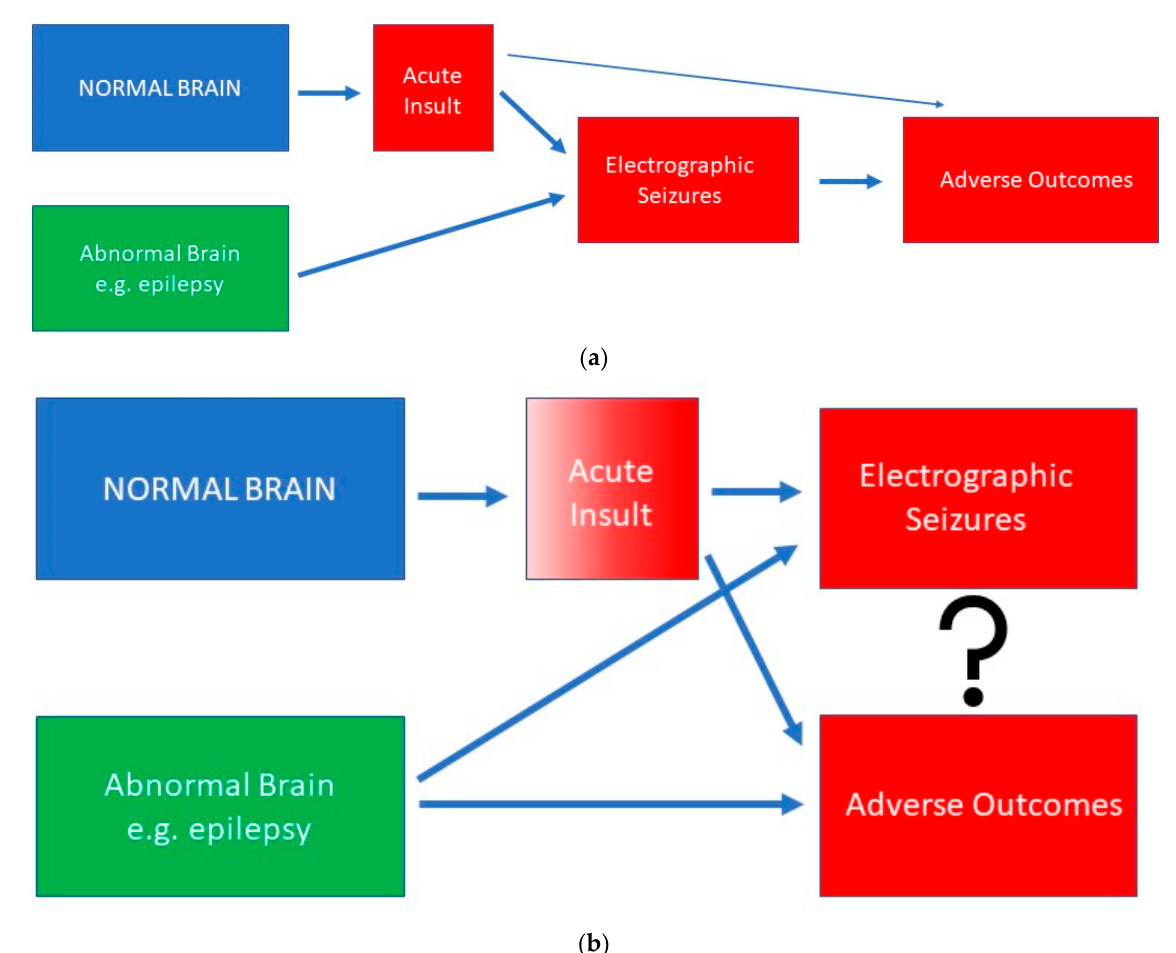
Figure 1. Conceptual framework for the relationships between electrographic seizures and adverse outcomes. ( a ) shows a causative relationship where the electrographic seizures per se make a significant contribution to outcomes. There is an impact of the underlying etiology, particularly if there is an acute neurological insult, but this currently receives less attention than the potential impact of electrographic seizures. ( b ) shows a correlation where the etiology is the main predictor of outcomes. As the severity of the insult increases, the likelihood that electrographic seizures will occur increases and the likelihood of an adverse outcome increases. The impact of electrographic seizures on the outcomes is likely small and only in the context of electrographic status epilepticus.